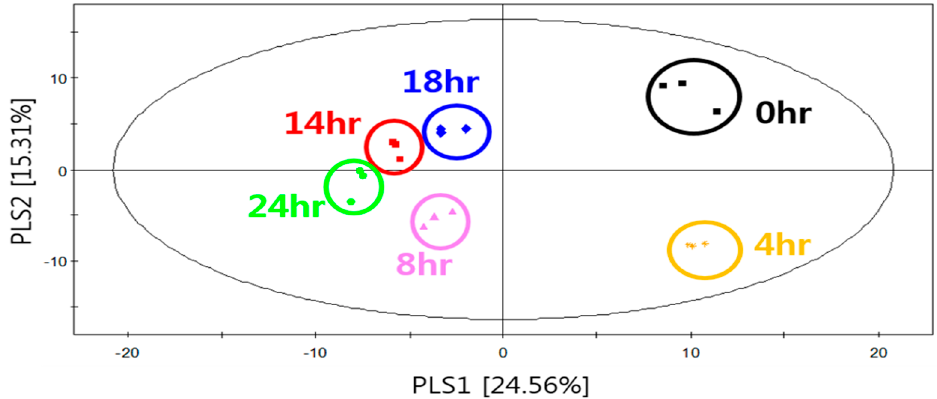
Figure 3. PLS-DA score plot for the volatile metabolites of of S. fibuligera KJJ81 in YPD medium according to the cultivation time.